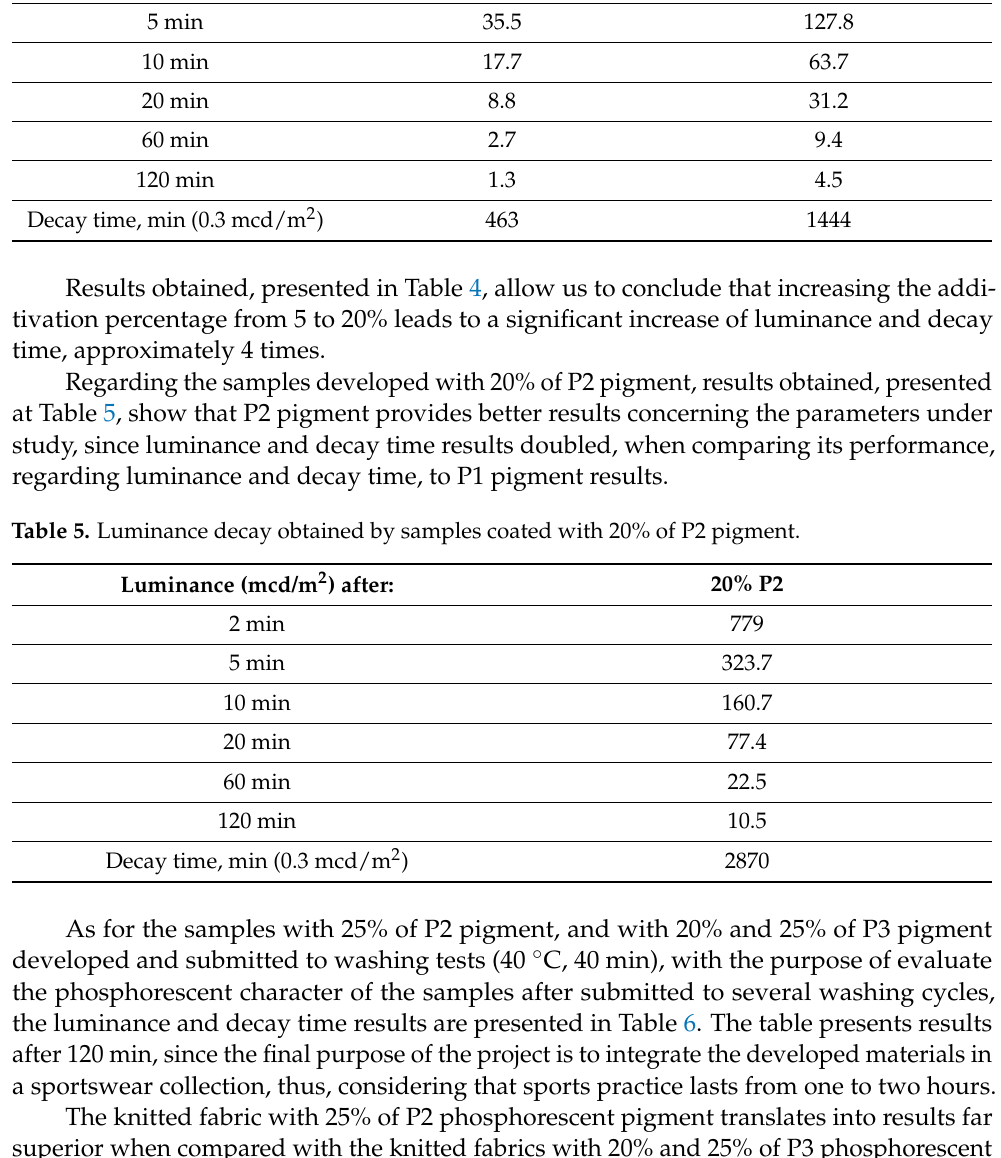
Table 4. Luminance decay obtained by samples coated with 5 and 20% of P1 pigment. Luminance (mcd/m 2 ) after: 5% P1 20% P1 2 min 88